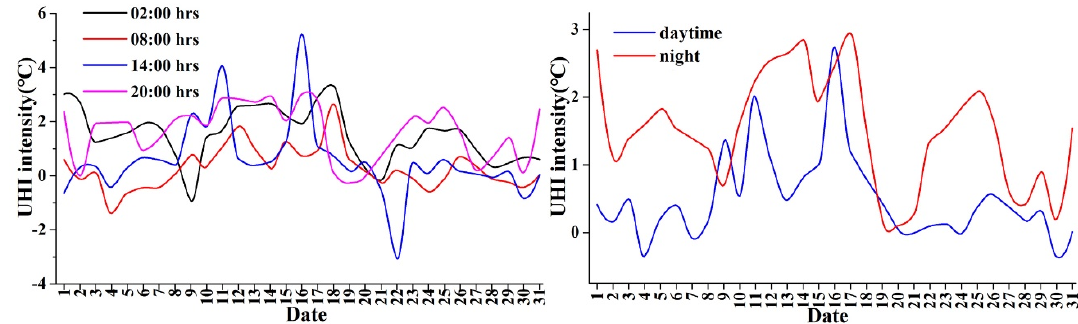
Figure 6. The diurnal variations of UHI intensity at representative hours and in the daytime and nighttime during August 1–31, 2015.